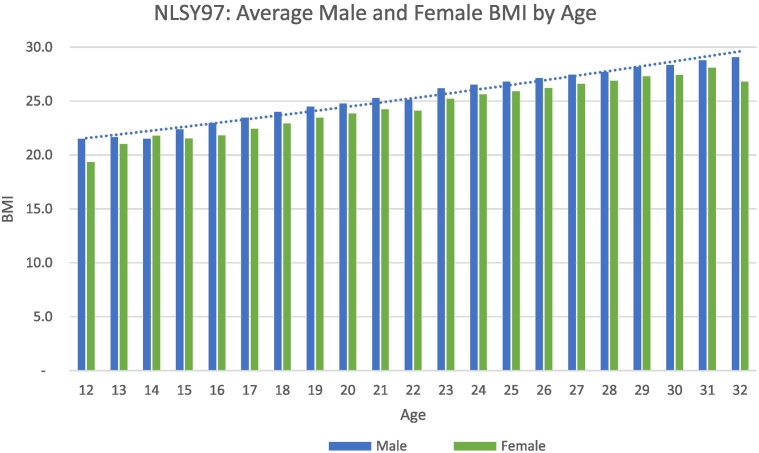
Average BMI by Age.